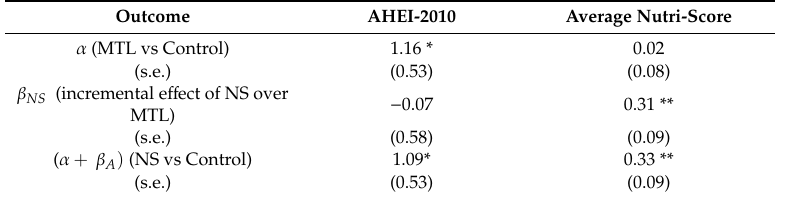
Table 3. Estimated e ff ects of Multiple Tra ffi c Lights (MTL) and Nutri-Score labels ( n = 147, N =